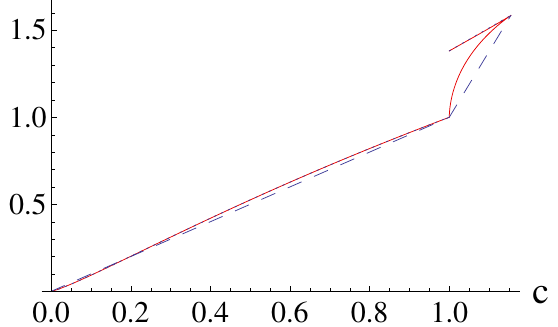
Figure 3. The plot of lower bound (dashed line) and upper bound (dotted line) for α = 0.6, m = 3. The upper bound consists of two segments and the lower bound also consists of two segments. The solid line corresponds to R 11 , R 12 and R 21